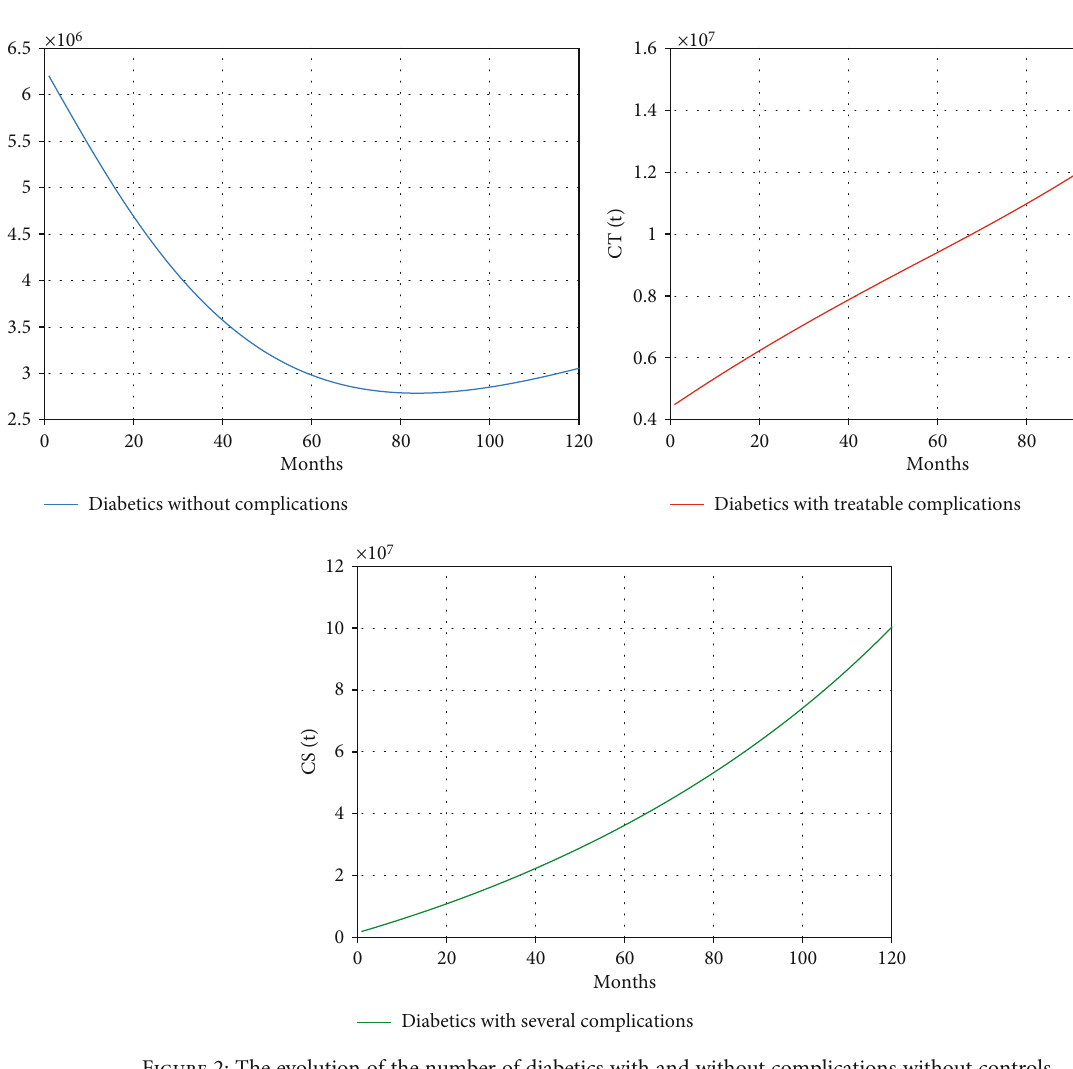
Figure 2: The evolution of the number of diabetics with and without complications without